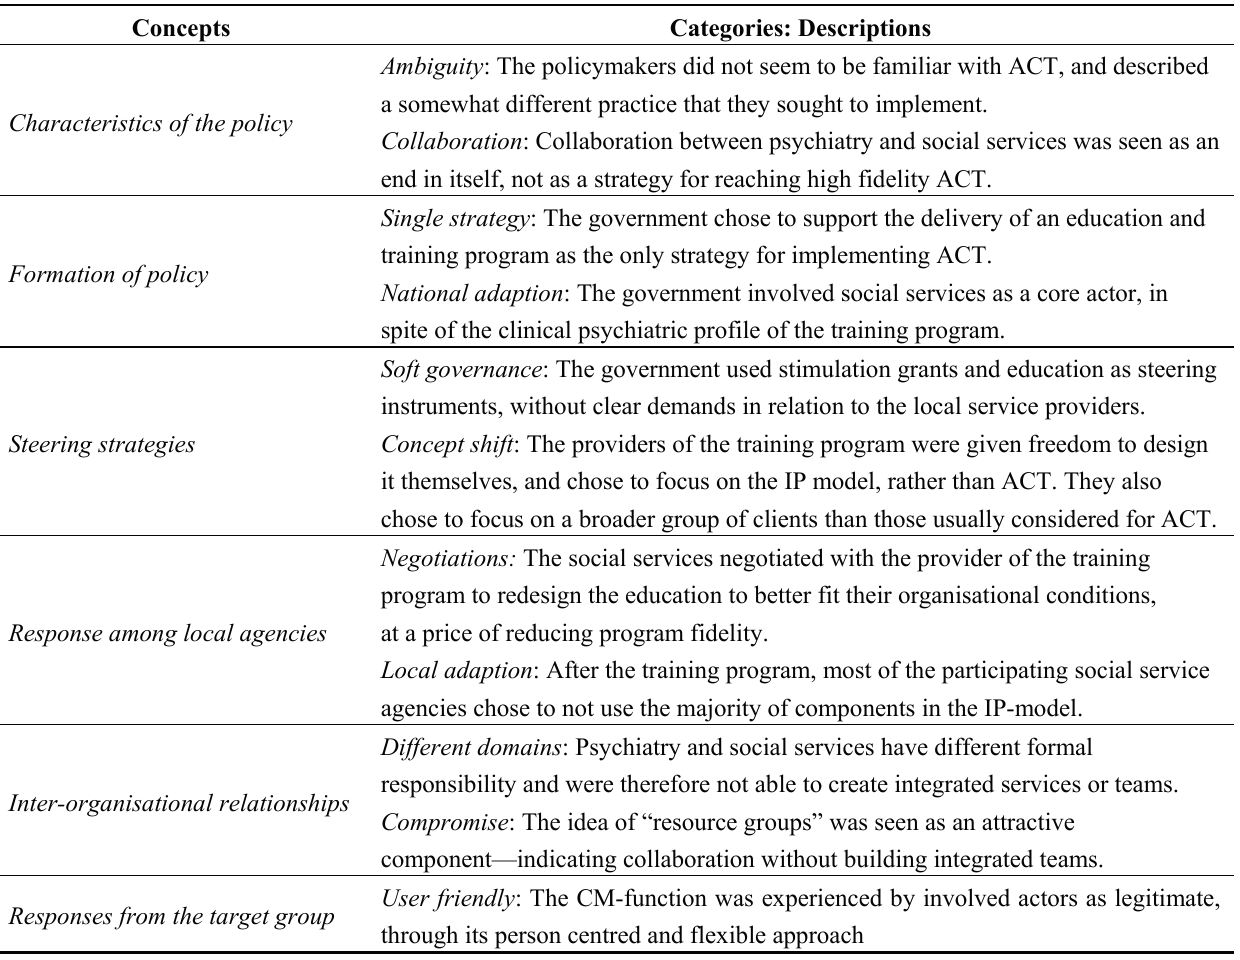
Table 5. Summary of